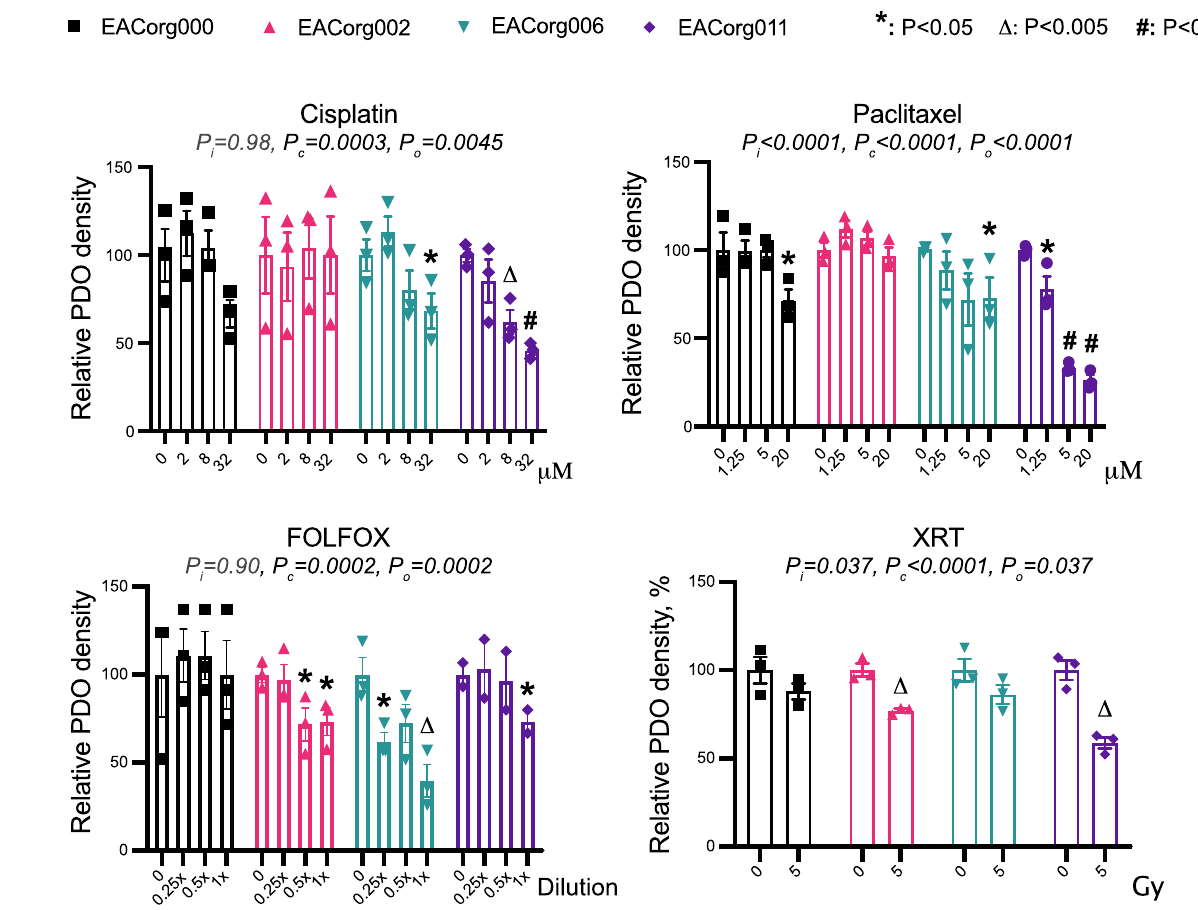
Figure 3. EAC PDOs serve as avatars for patients’ responses to therapy. Relative PDO density in response to components of standard of care and alternative treatments. 2-way ANOVA parameters: P i = significance of interaction (differential responses of organoid lines), P c = significance of concentration/dose, P o = significance of organoid line. Error bars = SEM, * P < 0.05, Δ P < 0.005, # P <